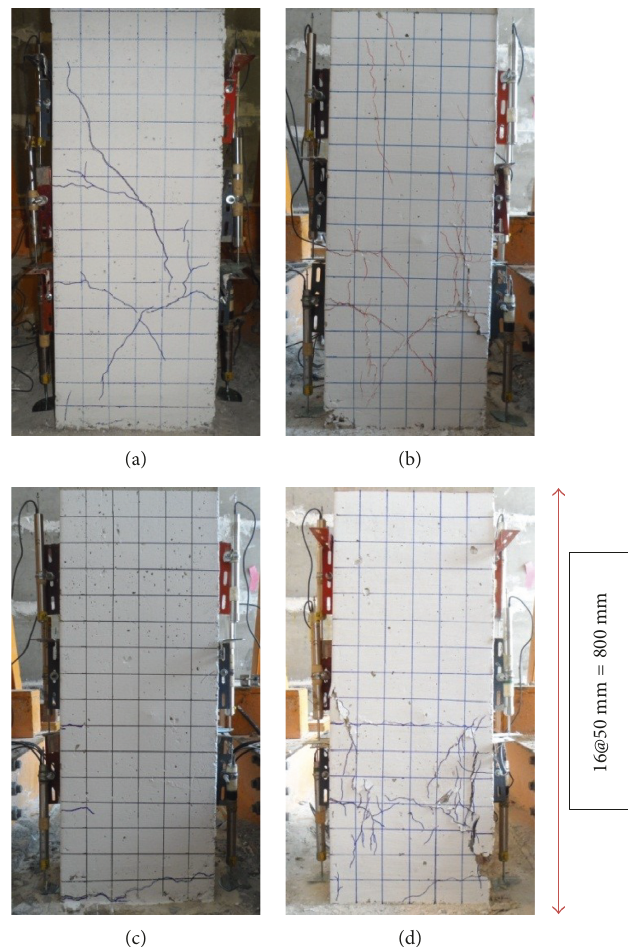
Figure 5: The levels of damage at the rate of lateral movement (at 1.5% drift). (a) 12L-0.2, (b) 12L-0.6, (c) 9L-0.2, and (d)